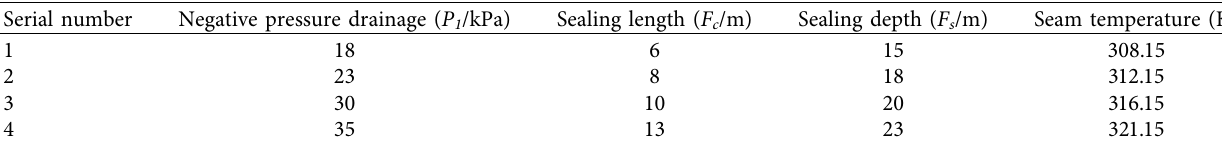
Figure 3: Relationship between maximum temperature of coal around the drilling hole and the drainage time under different negative pressure conditions. Table 1: Parameters and their values.